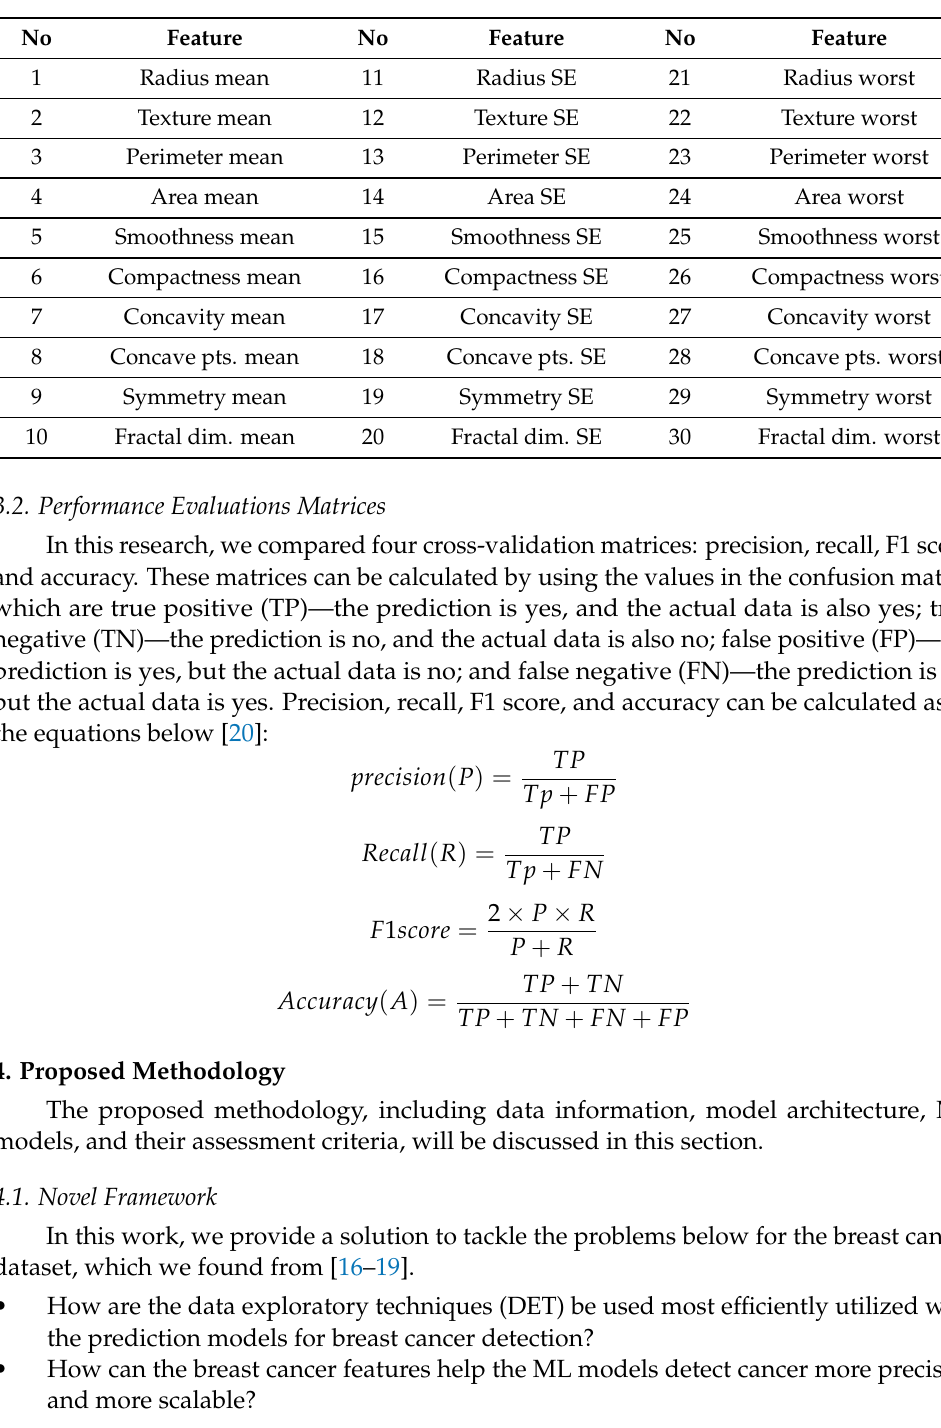
Table 1. Features categorization of WDBC